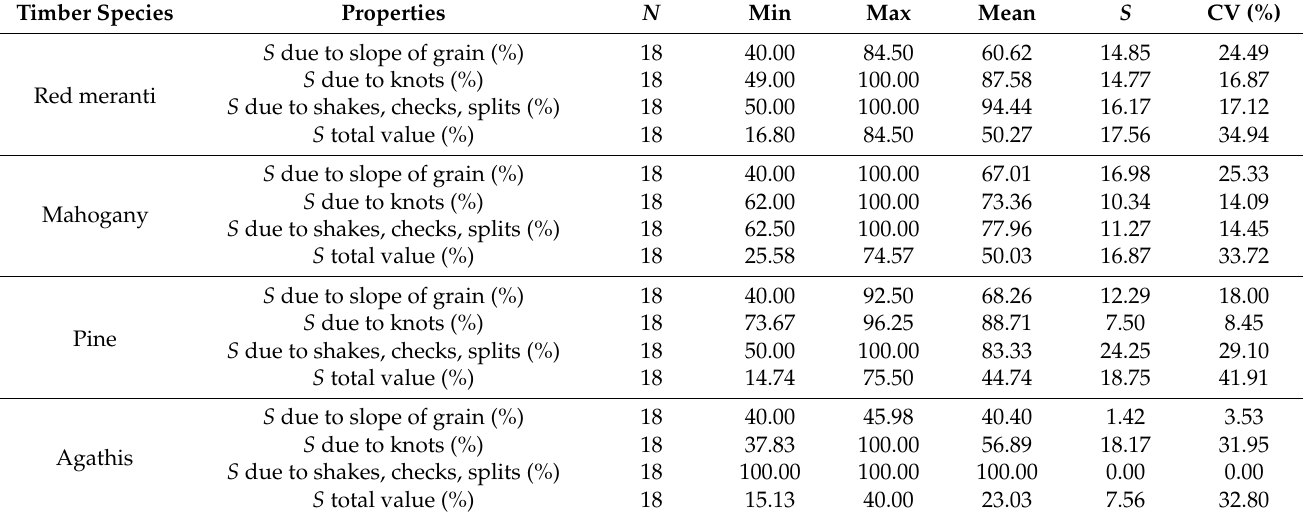
Table 6. The full-size specimens’ strength ratio ( S